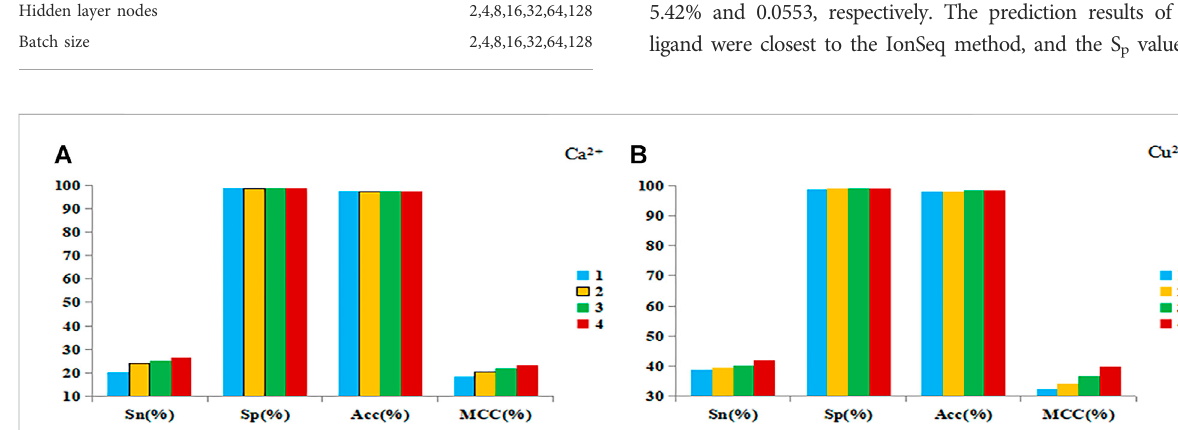
FIGURE 4 The results of 5-fold cross-validation of Ca 2+ (A) and Cu 2+ (B) ligands. Note: The abscissa is the four evaluation indexes, and the ordinate is the value of the evaluation index. The ordinate is the value of the evaluation index. The blue bar represents the prediction results of the basic feature parameters, the yellow bar represents the prediction results of 1+propensity factor, the green bar represents the prediction results of 1+disorder value, and the red bar represents the prediction results of 2+ disorder value.